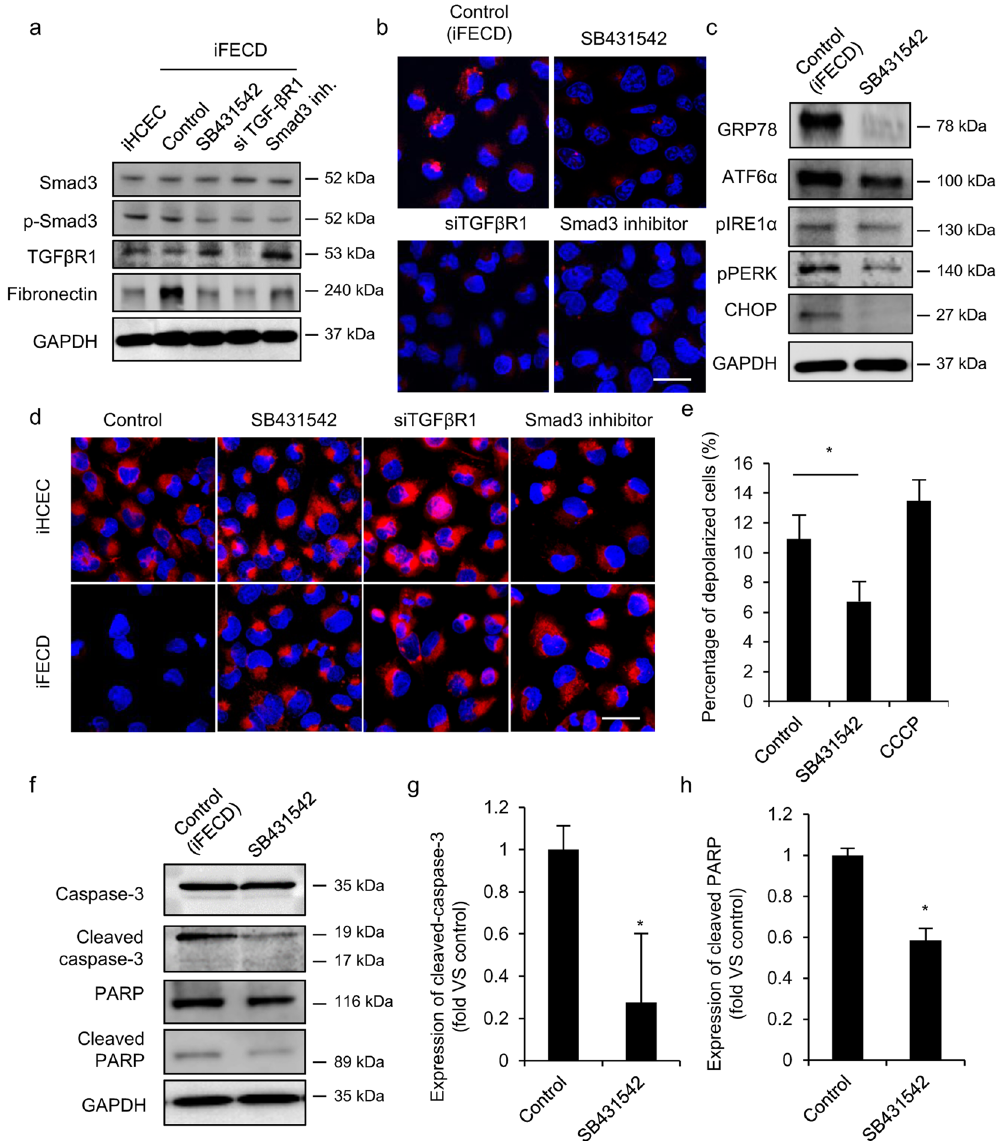
Figure 5. Effect of inhibiting TGF- β signaling pathway on endoplasmic reticulum (ER) stress mediated cell death. The effect of inhibiting TGF- β signaling pathway on extracellular matrix (ECM) production was evaluated. iFECD was cultured with SB431542 (TGF- β R1 inhibitor) or Smad inhibitor, or knockdown TGF- β R1 by siRNA. Phosphorylation of Smad3 was suppressed by SB431542, knockdown TGF- β R1, and Smad inhibitor. Production of fibronectin by iFECD was evaluated by western blotting. Experiments were performed in duplicate. ( b ) TGF- β signaling pathway was blocked by SB431542 (TGF- β R1 inhibitor) or Smad inhibitor, or knockdown TGF- β R1 by siRNA. The effect of TGF- β signaling pathway inhibition on unfolded protein was evaluated by aggresome staining. Experiments were performed in triplicate. Scale bar: 50 µ m. ( c ) Effect of inhibition of the TGF- β signaling pathway on endoplasmic reticulum (ER) stress. Expression of GRP78, ATF6 pIRE1 α , and CHOP, and phosphorylation of IRE1 α and PERK was evaluated by western blotting. GAPDH was used as internal control. Experiments were performed in triplicate. ( d , e ) Effect of inhibiting TGF- β signaling pathway on mitochondrial membrane potential (MMP) depolarization was evaluated by fluorescent microscope after JC-1 staining and flow cytometry. Nuclei were stained with DAPI for fluorescence microscopy analysis. CCCP was used as positive control to induce MMP depolarization. Experiments were performed in duplicate. Scale bar: 50 µ m. The statistical analysis was performed by Student’s t-test. * P < 0.01. ( f – h ) Western blotting was preformed to evaluate the effect of inhibiting TGF- β signaling pathway on cleavage caspase 3 and PARP. Full- length blots are presented in Supplementary Fig. 1. Densitometry analysis of three independent experiments was performed with ImageJ and plotted as graphs. The statistical analysis was performed with the Student’s t-test. * P <